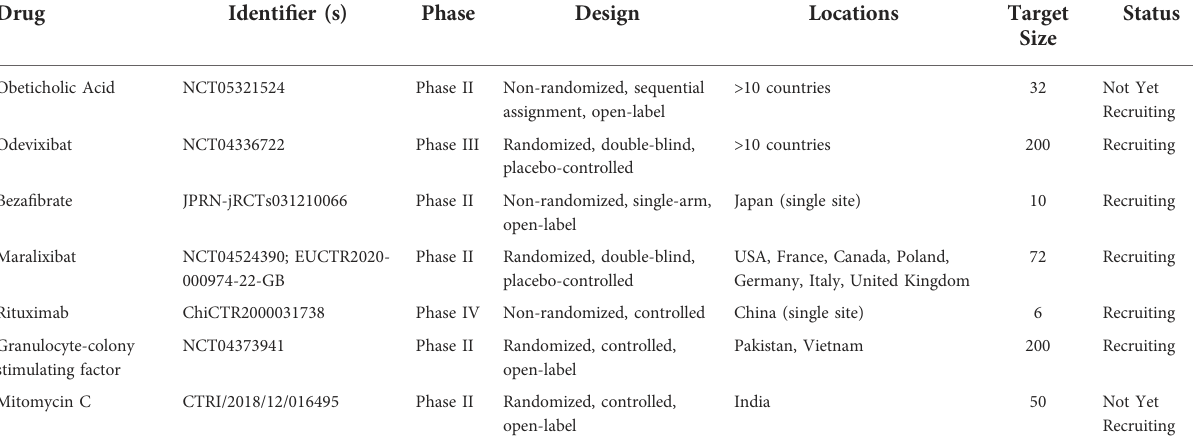
TABLE 1 Selected ongoing clinical trials investigating repurposed therapeutics for biliary